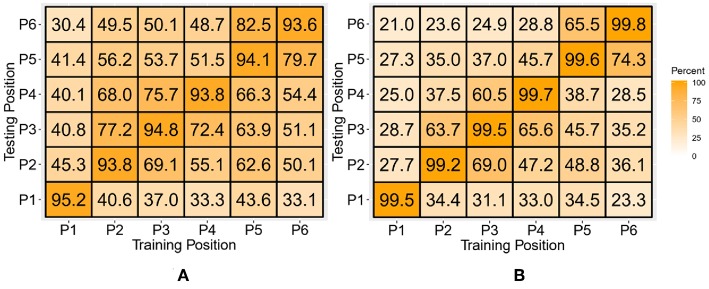
Interposition and intraposition classification accuracy matrices for LDA (A) and SVM (B) classifiers. The columns indicate the training positions, and rows indicate the testing positions for the classifiers.